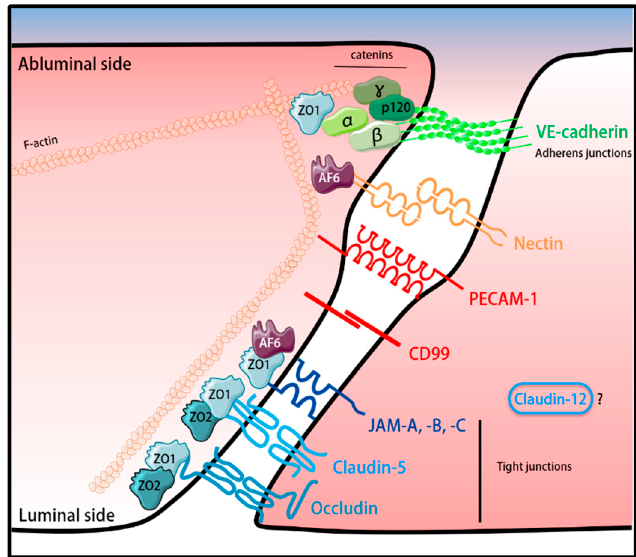
Figure 2. Schematic representation of the junctional complexes of the BBB. The proteins that compose the tight and adherens junctions are connected to the cytoskeleton via intracellular scaffolding proteins, ZO-1, ZO-2 and AF-6. Despite being expressed at low levels by the BBB endothelial cells [106], the subcellular location and function of claudin-12 remains to be defined. The forms of the individual proteins were adapted from Servier Medical Art (http://smart.servier.com/), licensed under a Creative Common Attribution 3.0 Generic License.